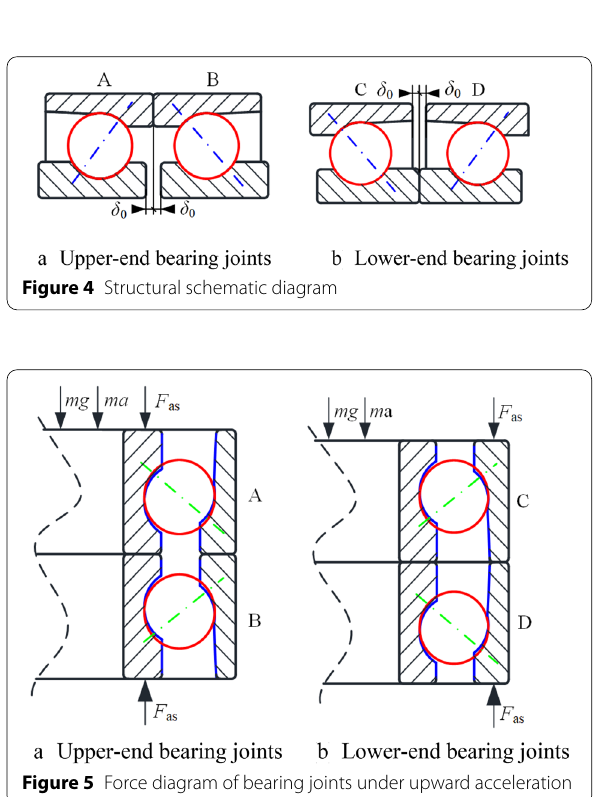
(1) Upward acceleration Figure 5(a)–(b) show the force analysis of the upper- and lower-end bearing joints, respectively. As shown in Figure 5(a)–(b), there are three forces acting on the upper- and lower-end bearing joints, namely, the screw tension force, spindle system weight, and inertial force. Under the action of the screw-tension force, the clearance formed by the protrusion of bearings A and B, as well as that between bearings C and D, is eliminated. The other two forces act on the bearing joints as external forces. The direction of the spindle system weight is downward, and the direc- tion of the inertial force is upward. Both forces are equally divided at the ends of the lead screw.